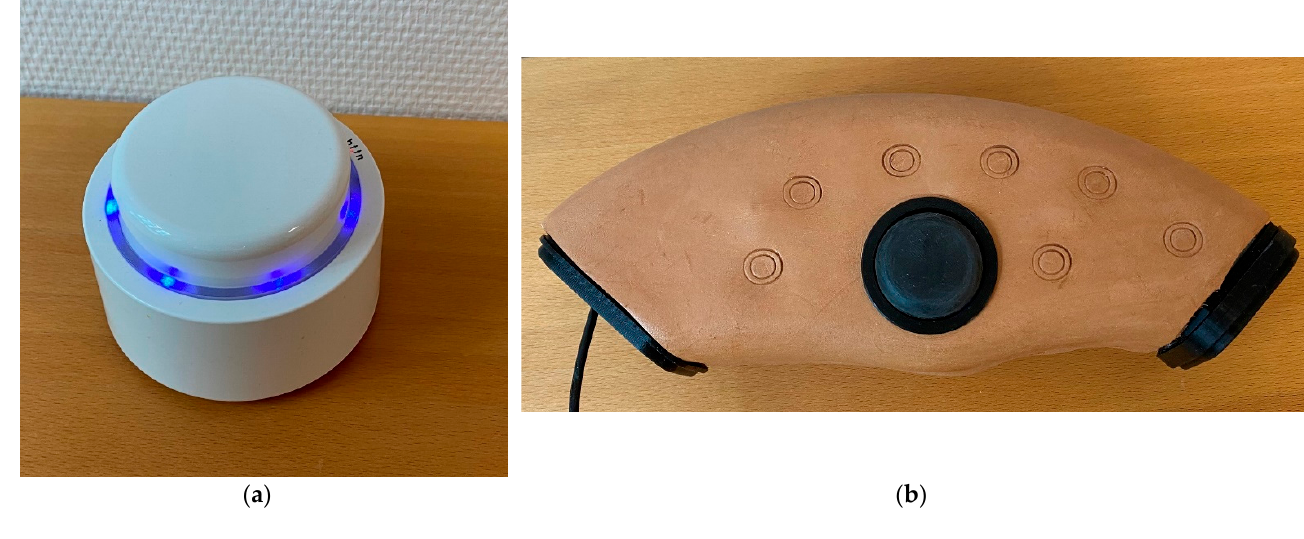
Figure 2. ( a ) Bluetooth button bt.tn; ( b ) Music device.